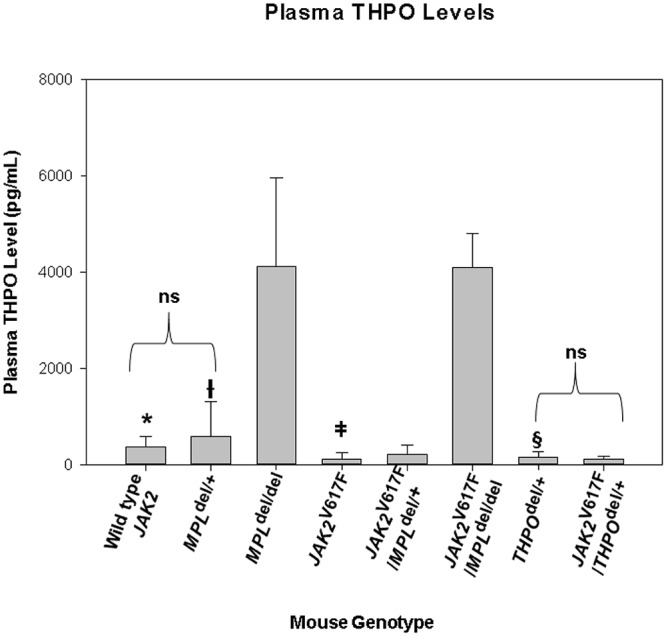
MPLdel and THPOdel genotypes alter the plasma THPO level in a JAK2V617F transgenic mouse model of PV.Plasma THPO was measured in wild-type (WT) (n = 26), MPLdel/+ (n = 16), MPLdel/del (n = 8) and THPOdel/+ (n = 11) mice and JAK2V617F (n = 21), JAK2V617F/MPLdel/+ (n = 13), JAK2V617F/MPLdel/del (n = 8) and JAK2V617F/THPOdel/+ (n = 4) transgenic mice. WT vs JAK2V617F, *P <0.001; MPLdel/+ vs JAK2V617F/MPLdel/+, ƗP < 0.01; JAK2V617F vs JAK2V617F/MPLdel/+, ǂP = 0.004; WT vs THPOdel/+, §P <0.001. The data are shown as means +/- the standard deviation. ns = not significant. The number (n) of mice of each genotype studied is in parentheses.